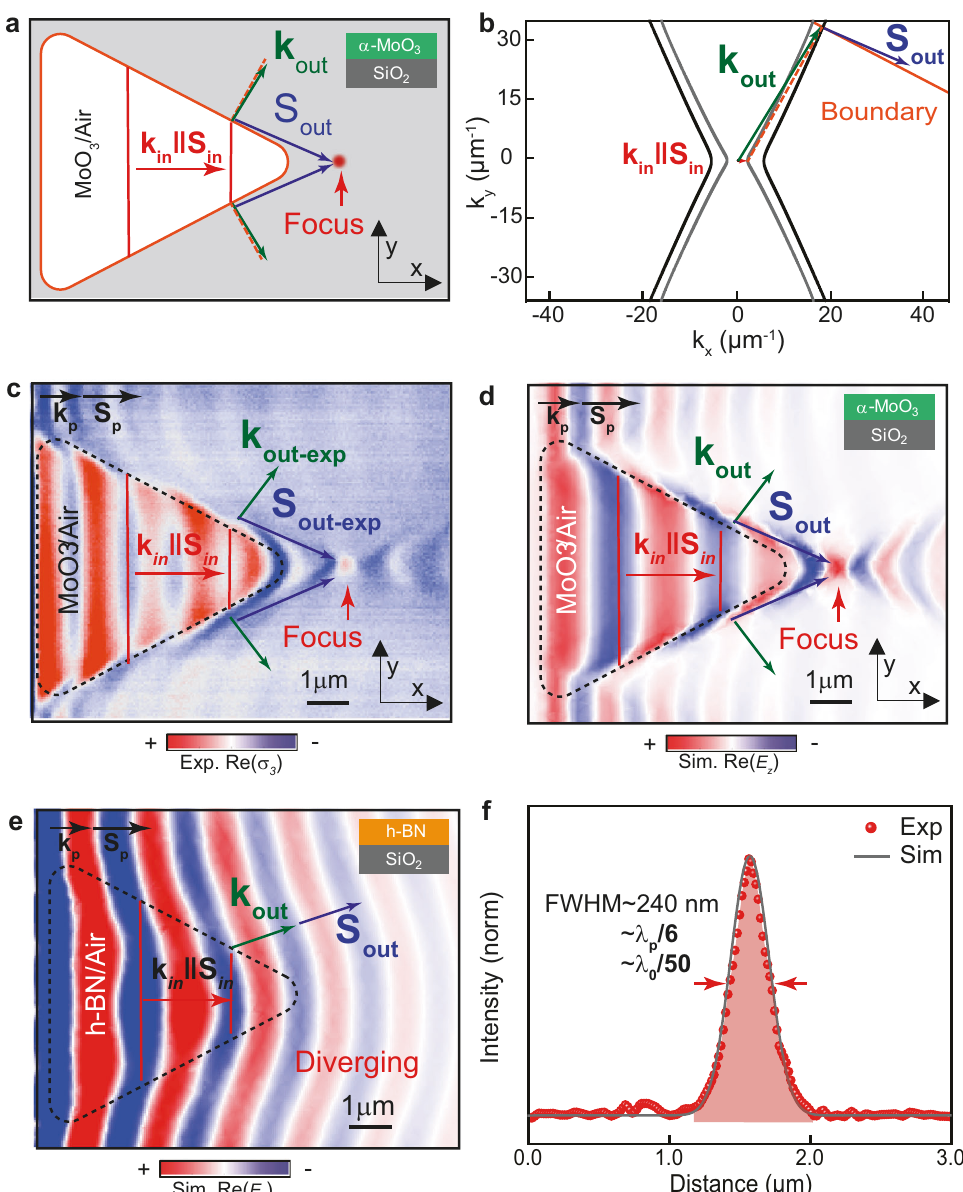
Fig. 3 Sub-diffractional planar lens based on refraction of HPhPs. a Schematics of a refractive hyperbolic lens fabricated by etching a triangular air cavity on the SiO 2 substrate below the α -MoO 3 fl ake. The top and bottom boundaries of the lens have the same slope as the boundary in b . Upon refraction at the boundaries (orange contour line), polaritons bend far away from the normal, S out (blue arrows), with a tilted wavevector k out (green arrows), converging at a focal spot (red dot). S in and k in display the direction of propagation and the wavevector of incident polaritons in α -MoO 3 /air, respectively. b Analytic isofrequency curves (IFCs) of polaritons propagating in α -MoO 3 /SiO 2 (black hyperbola) and α -MoO 3 /air (gray hyperbola). When the boundary (orange line) is nearly perpendicular to the asymptote of the open hyperbolic IFC, the refracted polaritons propagate ( S out , blue arrows) almost parallel to the boundary with large non-collinear wavevector ( k out , green arrows). c Experimental near- fi eld image of the refractive planar hyperlens (black dashed line) for polaritons in a 170-nm-thick α -MoO 3 slab, at λ 0 = 11.16 μ m. The polaritons converge upon refraction at the triangular boundary. Compared to non- refracted polaritons, indicated by k p and S p (black arrows) the refracted polaritons, S out (cid:2) exp (blue arrows), propagate nearly parallel to the boundary. d Simulated near- fi eld image of the refractive planar hyperlens (black dashed line) considered in b and visualized in c . e , Simulated near- fi eld image of a refractive lens for in-plane isotropic polaritons in a 170-nm-thick h-BN slab, at λ 0 = 6.5 μ m. Upon refraction at the triangular boundary (black dashed line), polaritons bend towards the normal, S out (blue arrow), with collinear wavevector k out (green arrow), yielding a diverging effect. Horizontal propagation of non-refracted polaritons is marked as k p and S p . f Near- fi eld intensity pro fi les (gray line and red dots) extracted through the focus spot along the vertical direction in d and c , respectively. Both curves are normalized to the near- fi eld intensity far away from the lens and fl ake edges. Con fi nement factors as large as ~ λ p /6 and ~ λ 0 /50 are obtained with respect to the polariton and free-space light